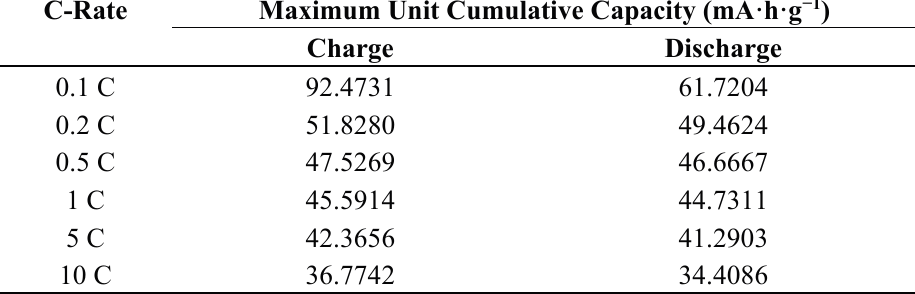
Table 4. Comparison of maximum unit cumulative capacity of coin cell charge and discharge at various